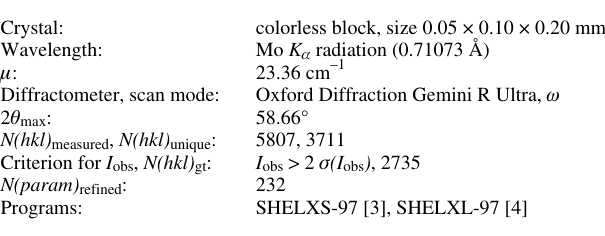
Table 1. Data collection and handling.